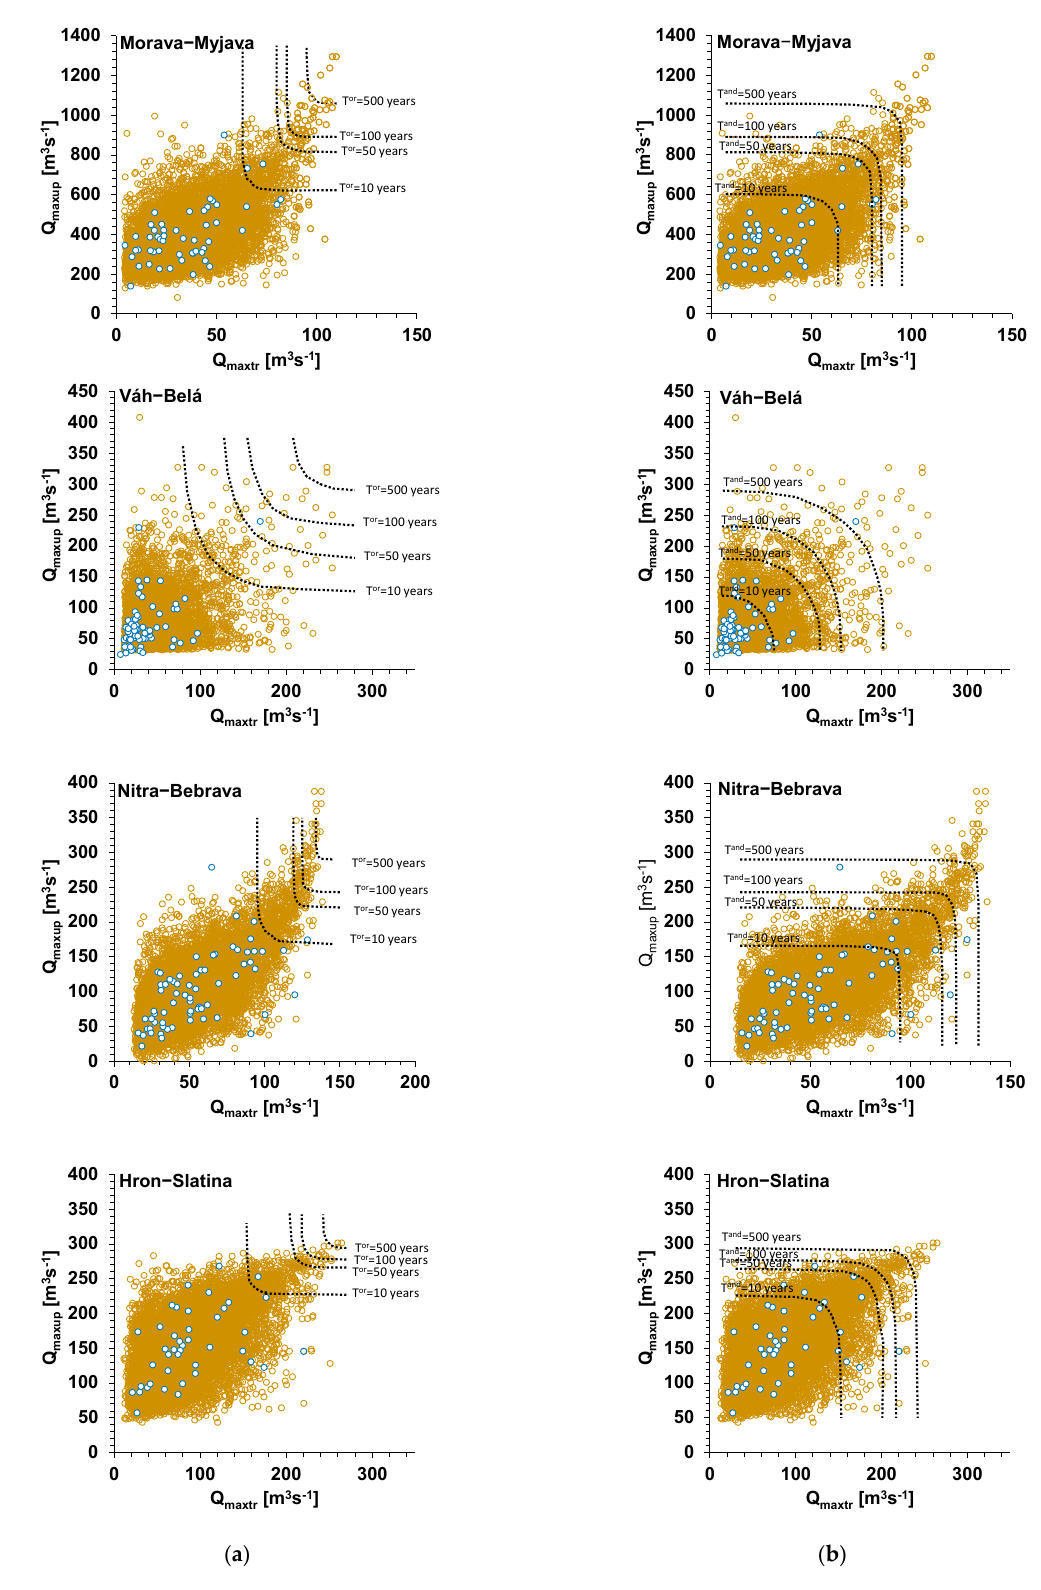
Figure 7. Scatter plots of 9000 data pairs generated from Gumbel–Hougaard copula and monitored data of the selected pairs Q maxup − Q maxtr . The contours in the return periods ( a ) in the case of “or” (X ≥ x or Y ≥ y, only one investigated variables exceeded a certain threshold value) and ( b ) in the case of “and” (X ≥ x and Y ≥ y, both investigated variables exceeded a certain threshold value). Table 5. Comparison of design discharges (Q 50 , Q 100 , Q 500 , Q 1000 ) based on univariate (Uni.) and based on the copula method at the mainstream stations below the confluences Q maxdwn .